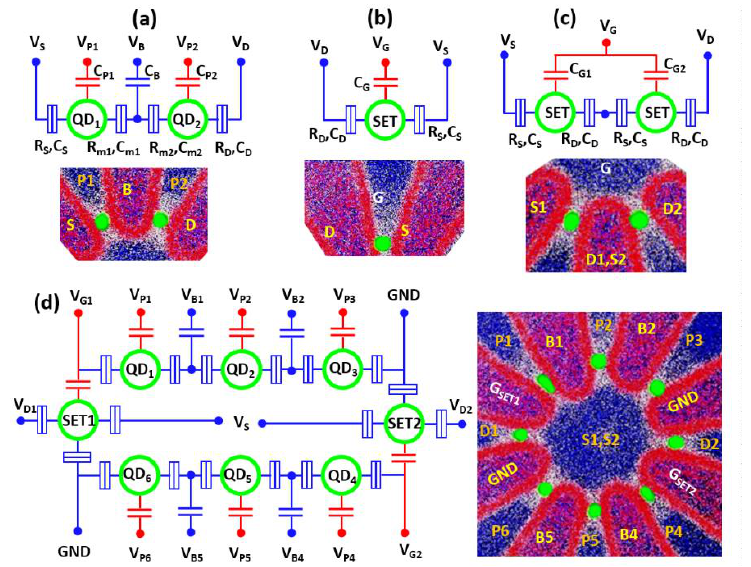
Figure 8. Possible configurations and layouts of Ge QD quantum electronic devices. ( a ) coupled DQDs as a qubit; ( b ) a QD-SET; ( c ) a SET logic inverter comprising two QD-SETs connected in series; and ( d ) a chain of QD-qubits integrated with two charge sensors of